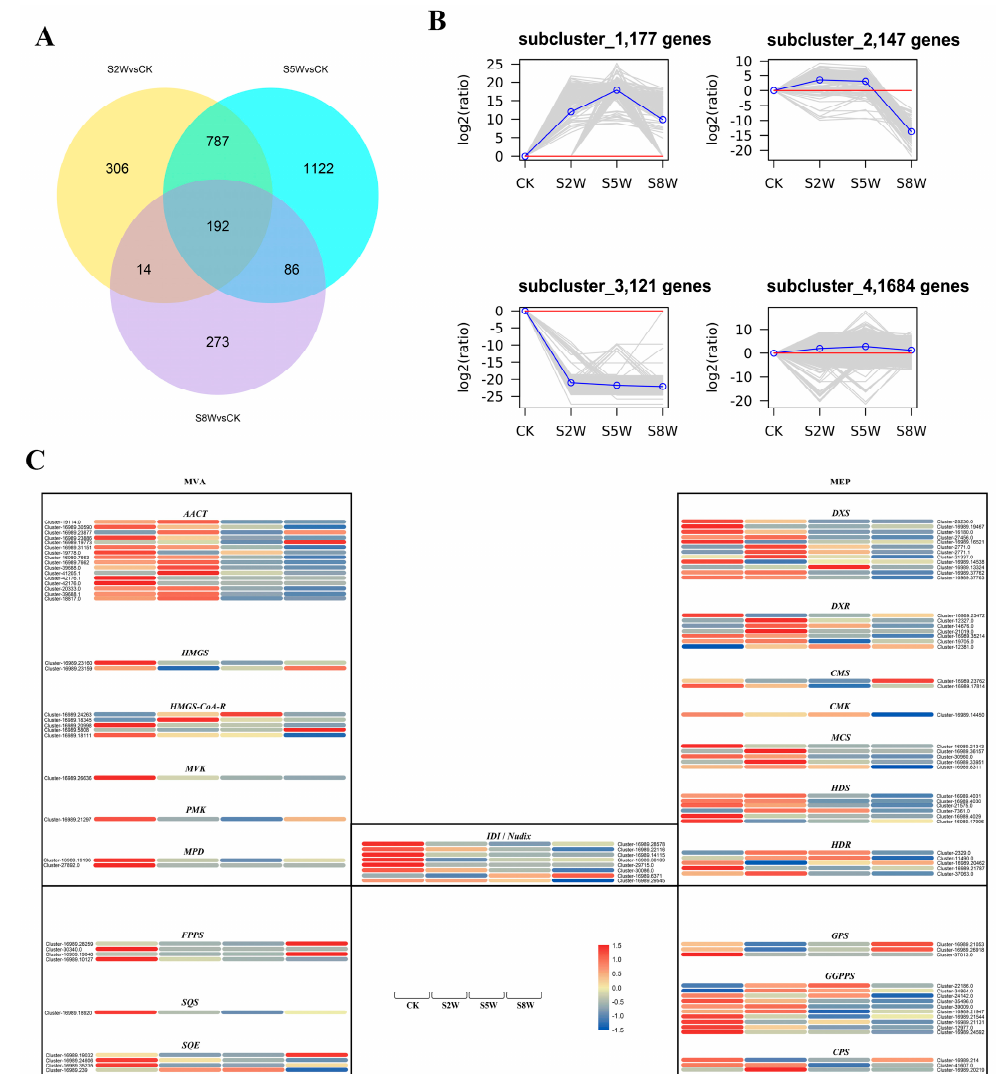
Figure 1. Conyza blinii transcriptome under NLT. The number of differentially expressed genes in S2W, S5W, and S8W. The intersecting part represents the common genes ( A ). All clusters were divided into four subclusters according to the expression trend. Above the red line is the up-regulated gene, and below the red line is the down-regulated gene ( B ). Gene expression of key enzymes in MEP and MVA metabolism pathways. Red represents high expression and blue represents low expression ( C ).